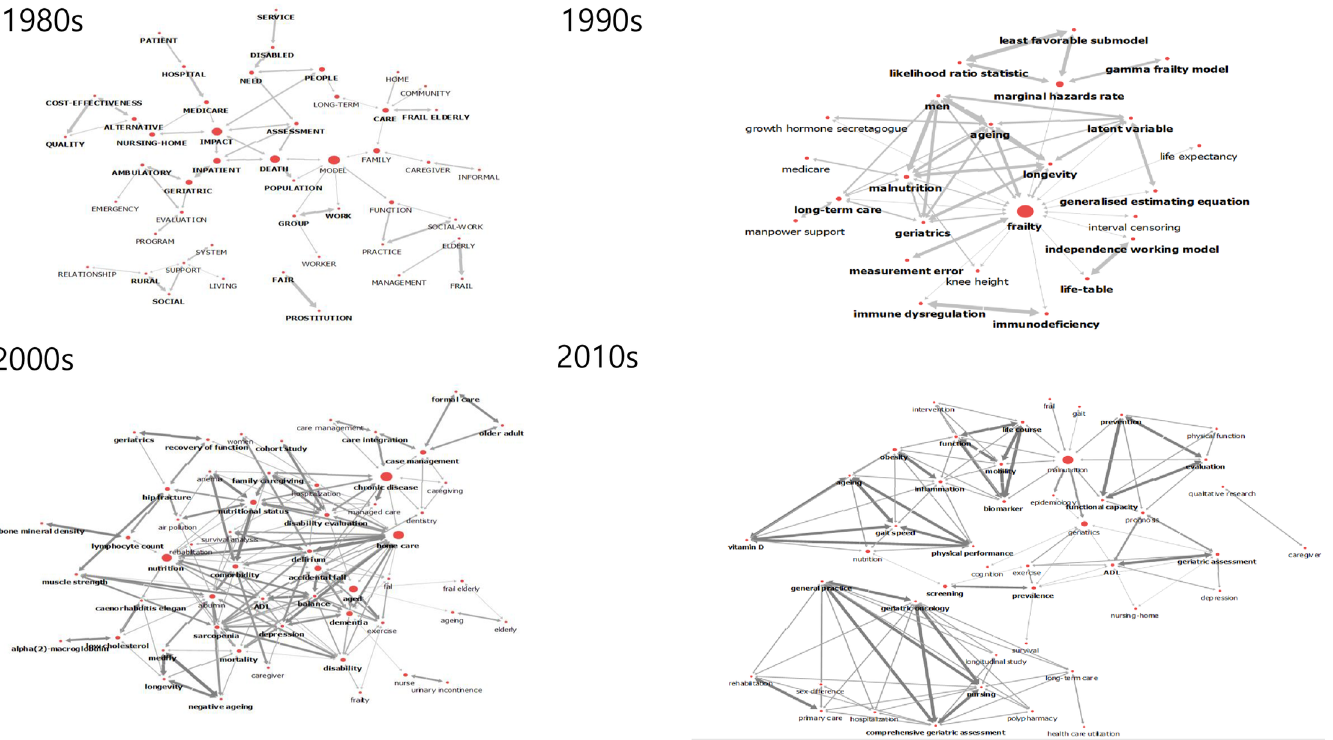
Fig 2. Betweenness centrality trend through 40 decades.